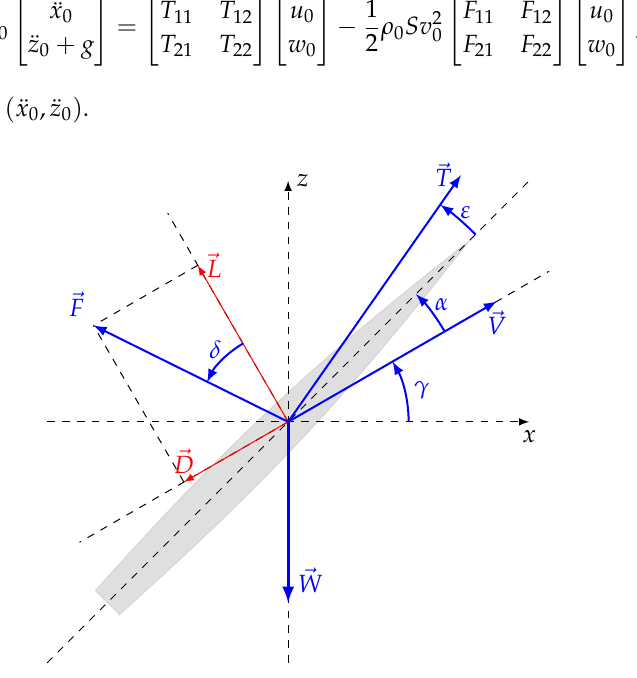
Figure 1. Forces on a rocket in flight (thrust T , weight W , drag D and lift L ) and relevant angles (angle-of-attack α , flight path angle γ , and thrust vector angle ε